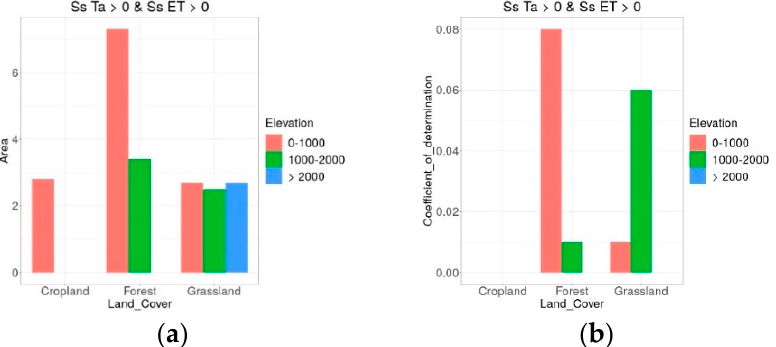
Figure 13. Percentage of area in each land cover class where tp and MOD16 ET trends overlap, per elevation ( a ) and corresponding r 2 ( b ). The combination of positive or negative ET and tp trends is indicated in the title of each plot. “Area” on the y axis is the percentage of the total area within each land cover class. Ss is the Sen’s slope of the trend at 5% significance from 2003 to 2019.